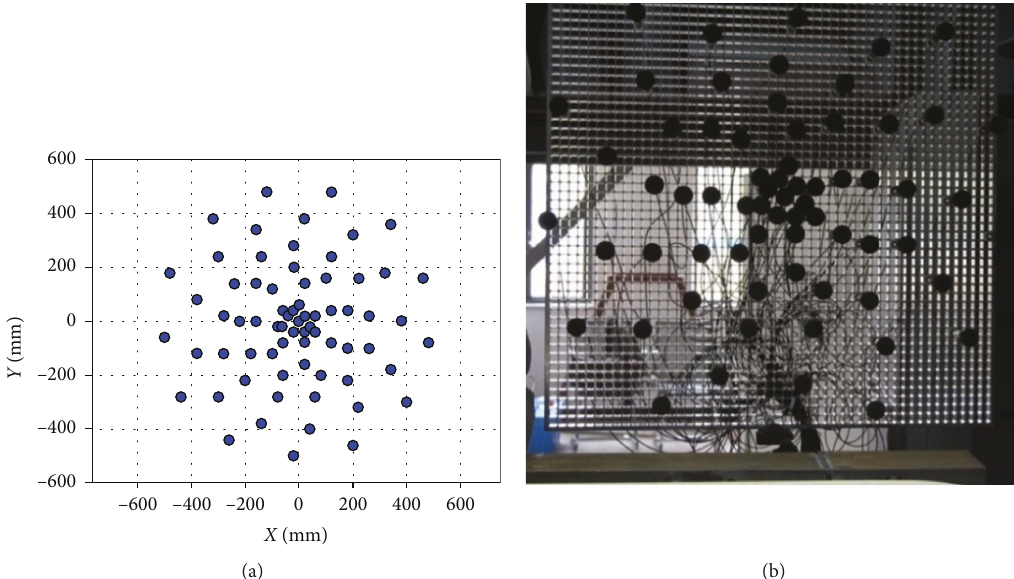
Figure 4: Microphone array used for the noise localization: (a) pattern of the microphone array; (b) front view of the microphone array. Case no.